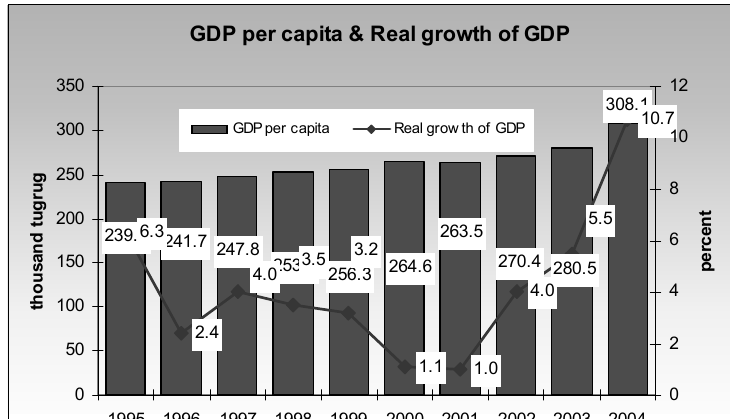
Fig. 7 – GDP per capital and real growth of GDP GDP per capita & Real growth of GDP